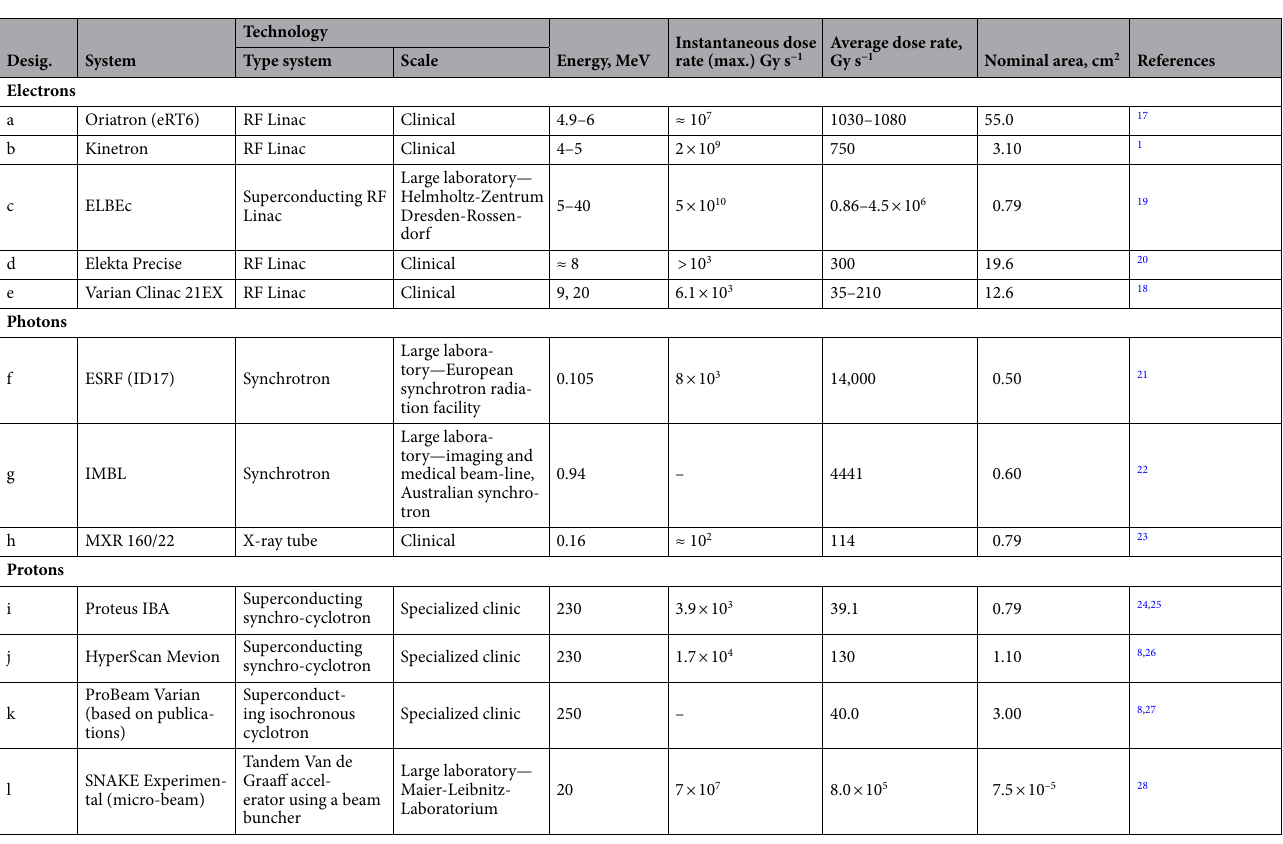
Table 1. Present methods of FLASH-RT